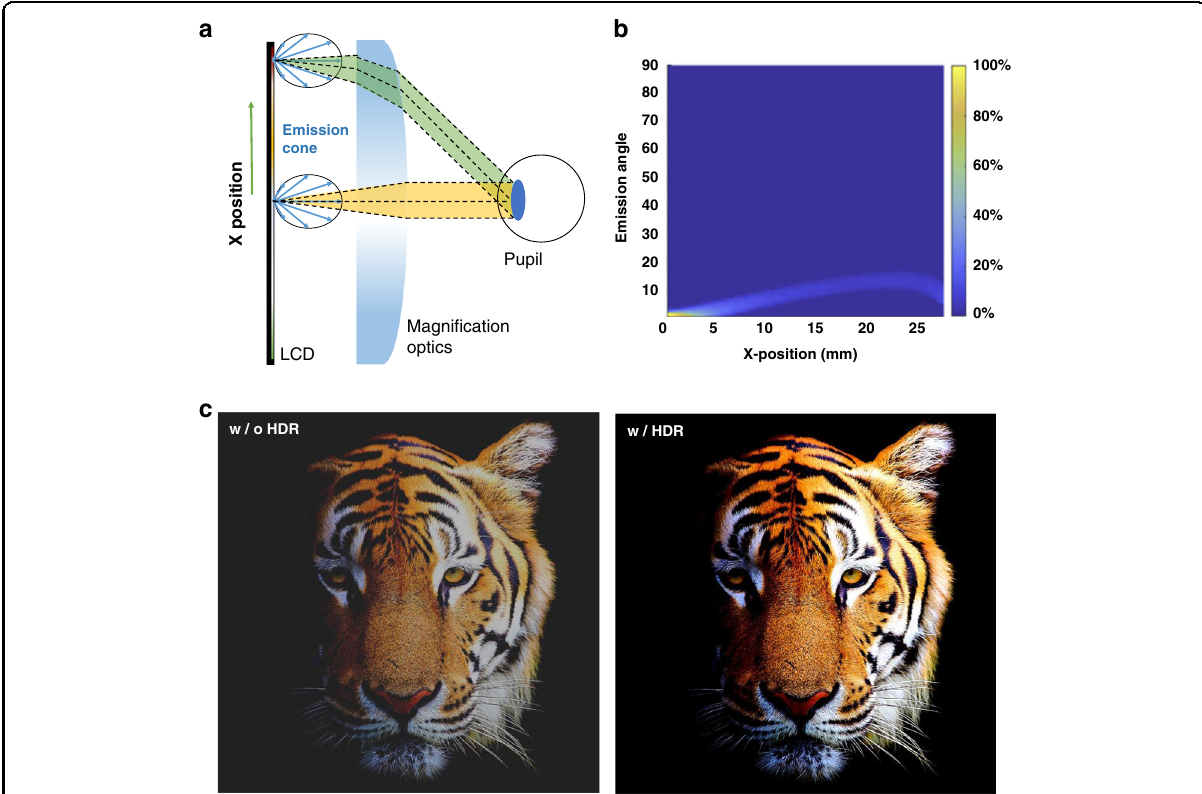
Fig. 3 Directional backlight displays. a Schematic of Fresnel lens in a normal VR system. b Simulated light collection ef fi ciency of different pixel positions. c Image comparison with and without local dimming. b ref. 63 . with permission from The Optical Society, and c ref. 53 with permission